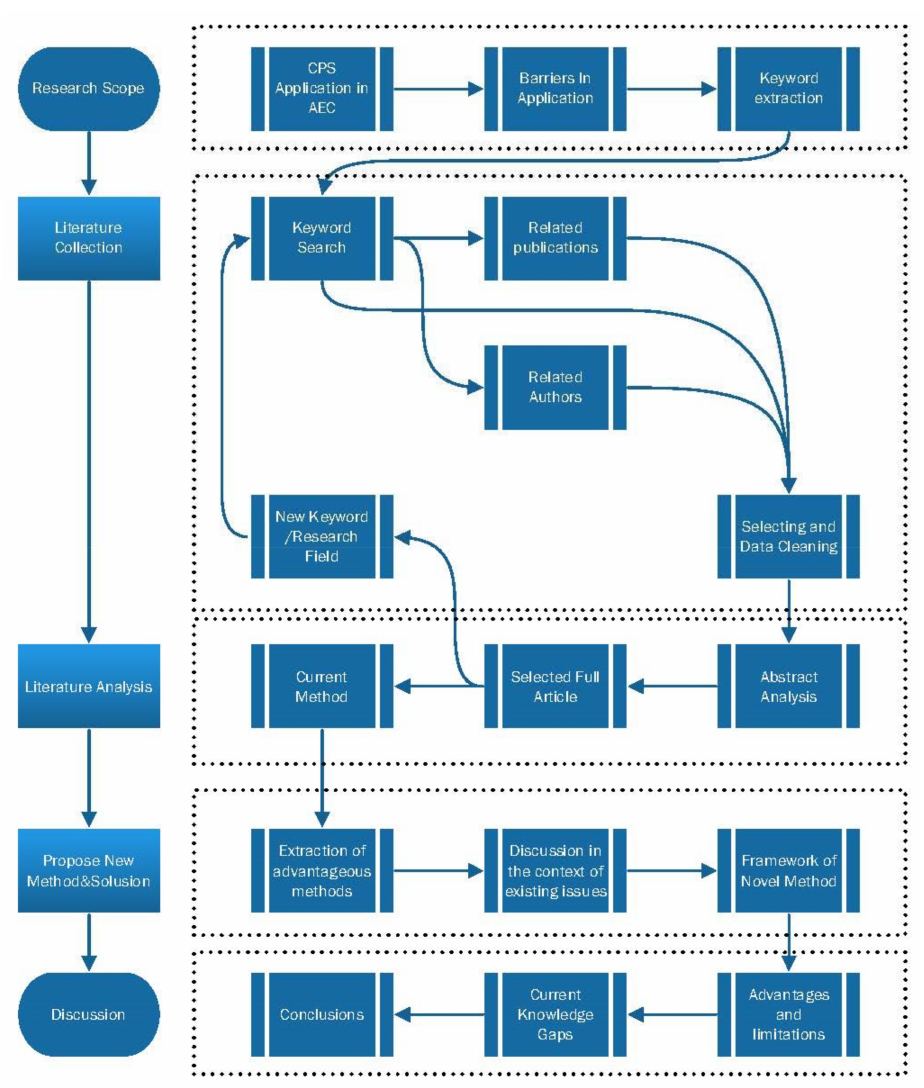
Figure 1. Research